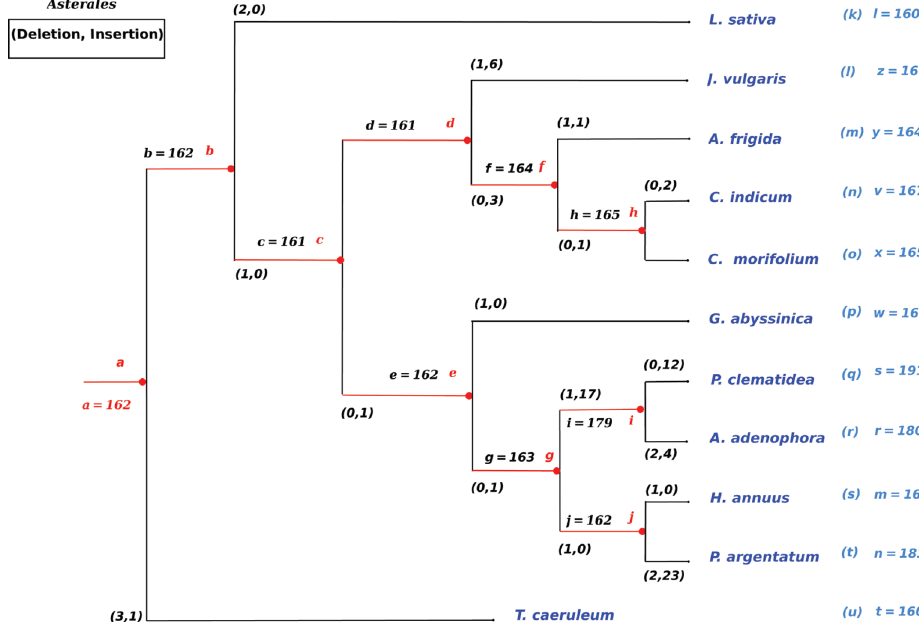
Figure 8: Summary of the complete ancestral genomes reconstruction of the Asterales order. Insertion and deletion events are provided, with names and length of each internal